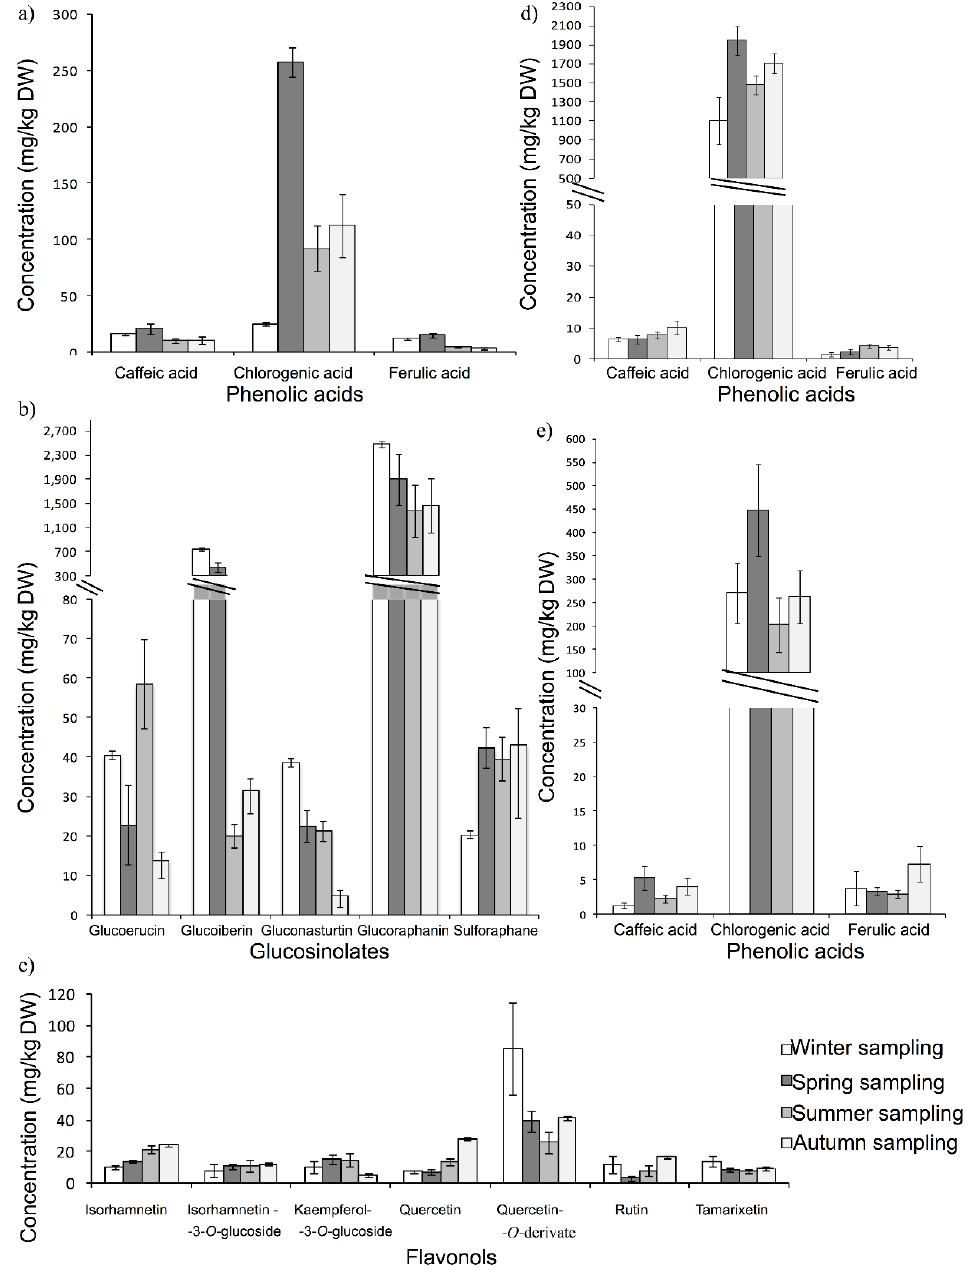
Figure 2. Concentration (mg/kg, dry weight (DW)) of the main family of phytochemicals in: ( a ) fresh-cut tomato; ( b ) fresh-cut broccoli; ( c ) fresh-cut grape; ( d ) fresh-cut eggplant; and ( e ) fresh-cut carrot during the different seasons of the